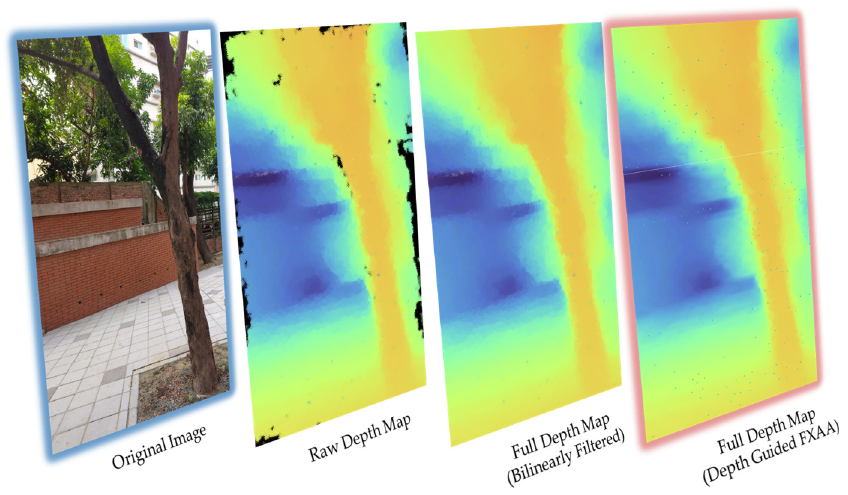
Figure 3. Processing visualization of full depth map generation starting from the original image to raw depth map to full depth map (bilinearly filtered), and, lastly, full depth map (depth-guided FXAA).